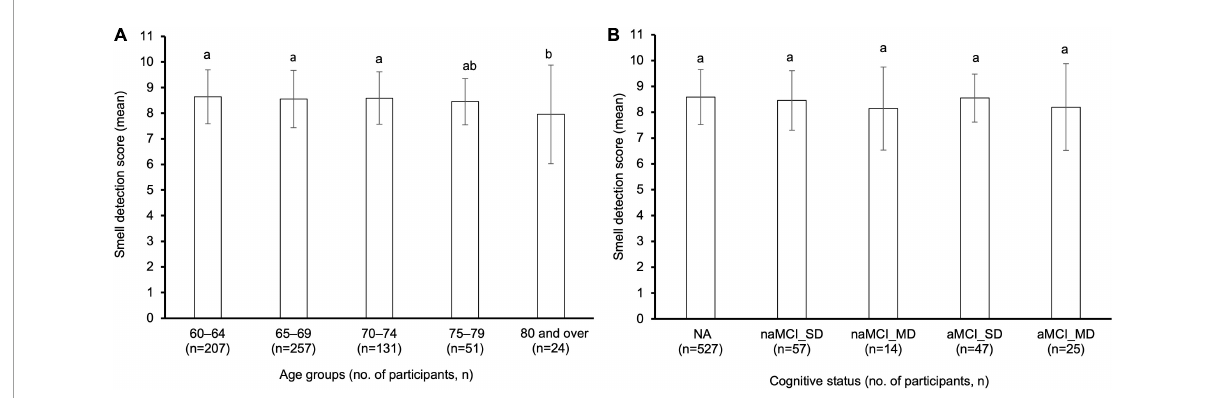
FIGURE2 (A) Comparison of smell detection score between five age groups and (B) five clinical diagnosis categories in 670 older adults. Bars denote geometric mean and standard deviation. Different letters (i.e., a and b) above the bars indicated a significant difference between age groups or the clinical diagnosis groups (one-way ANOVA, p < 0.05). n, number of participants; NA, normal aging; MCI, mild cognitive impairment; naMCI_SD, non-amnestic MCI single domain; naMCI_MD, non-amnestic MCI multiple domain; aMCI_SD, amnestic MCI single domain; aMCI_MD, amnestic MCI multiple domain.